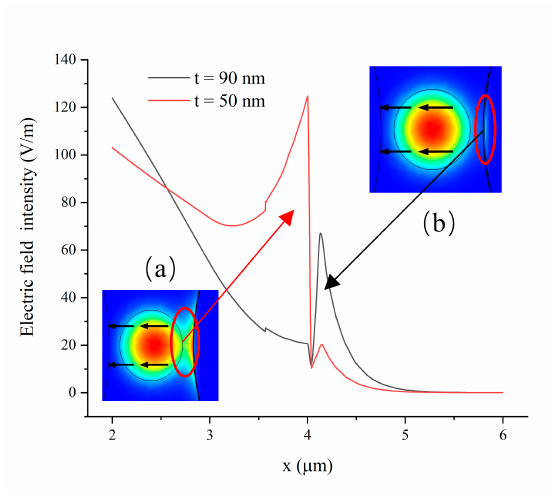
Figure 6. ( a ) The resonance spectra of the proposed sensor with di ff erent TiO 2 layer thickness t . ( b ) The full-width at half-maximum (FWHM) and sensitivity of the sensor under the di ff erent values of t . Photonics 2020 , 7 , x FOR PEER REVIEW The figure of merit (FOM) values along with the increases of t : 152.1, 140.4, 120.7, 96.8, and 84.3.